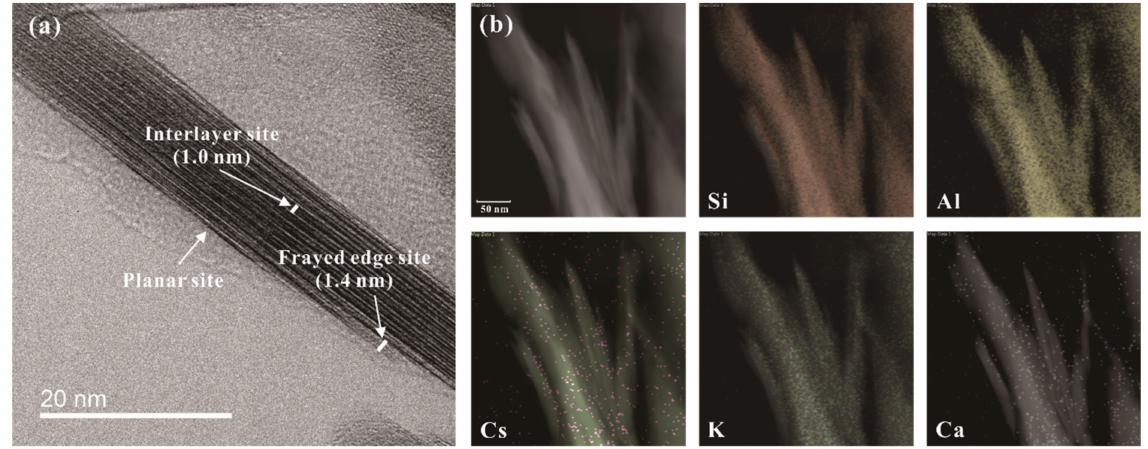
Figure 3. ( a ) TEM image of MI before cesium uptake, and ( b ) the TEM-EDS results of cesium-sorbed MI. The labeled points reveal the classified uptake sites distributed on the illite